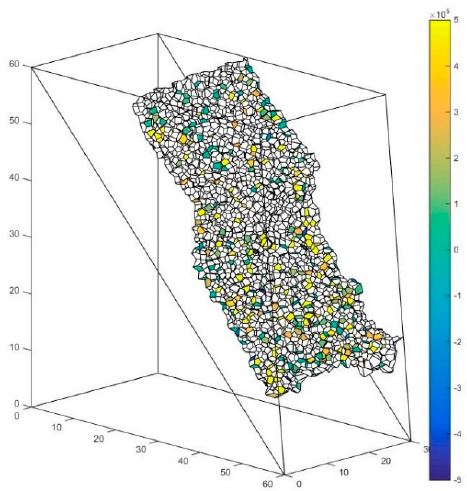
Figure 20. The contact force of the particle contact along the y-direction. Materials 2017 , 10 , 898